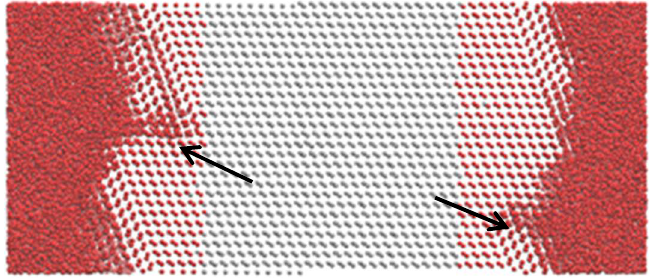
Figure 3. A snapshot of an example of dislocation formation in a strain-free <112> growth, at 1000 ps. The arrows indicate two locations of the dislocations formed.